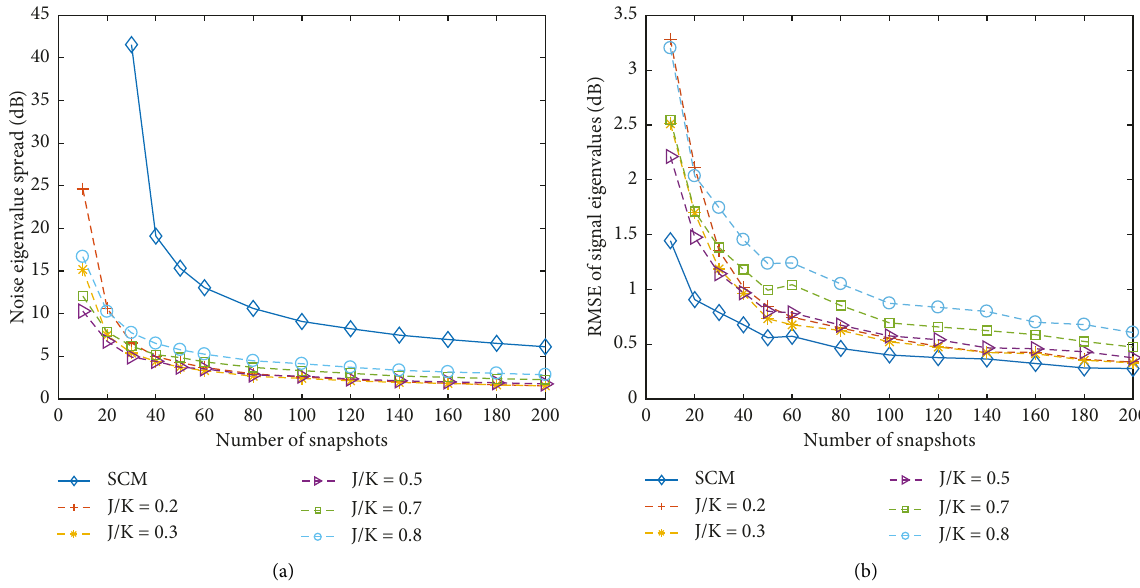
Figure 2: Estimation performance of different choices of J versus number of snapshots under case (ii), (SNR �− 20dB, Q � 3). (a) Noise eigenvalue spread. (b) Signal eigenvalue